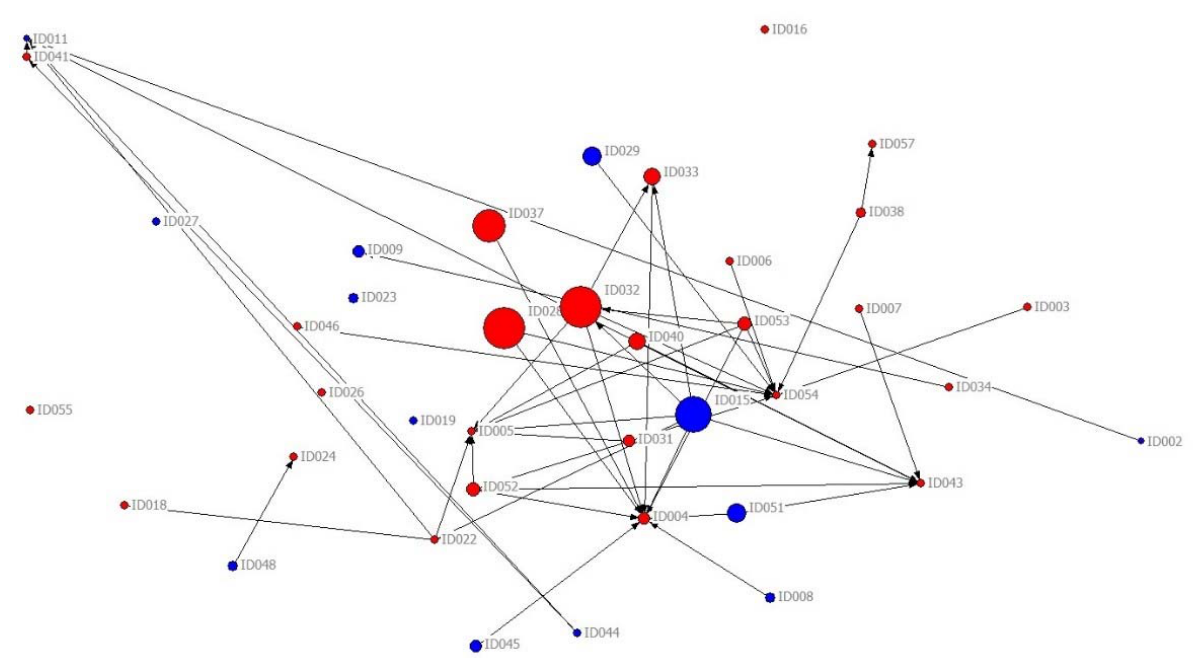
Figure 3. Managerial knowledge network.